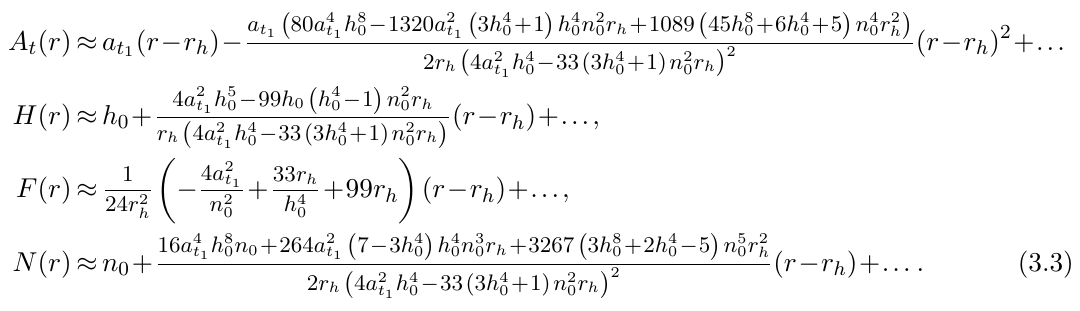
Near the horizon the functions behave